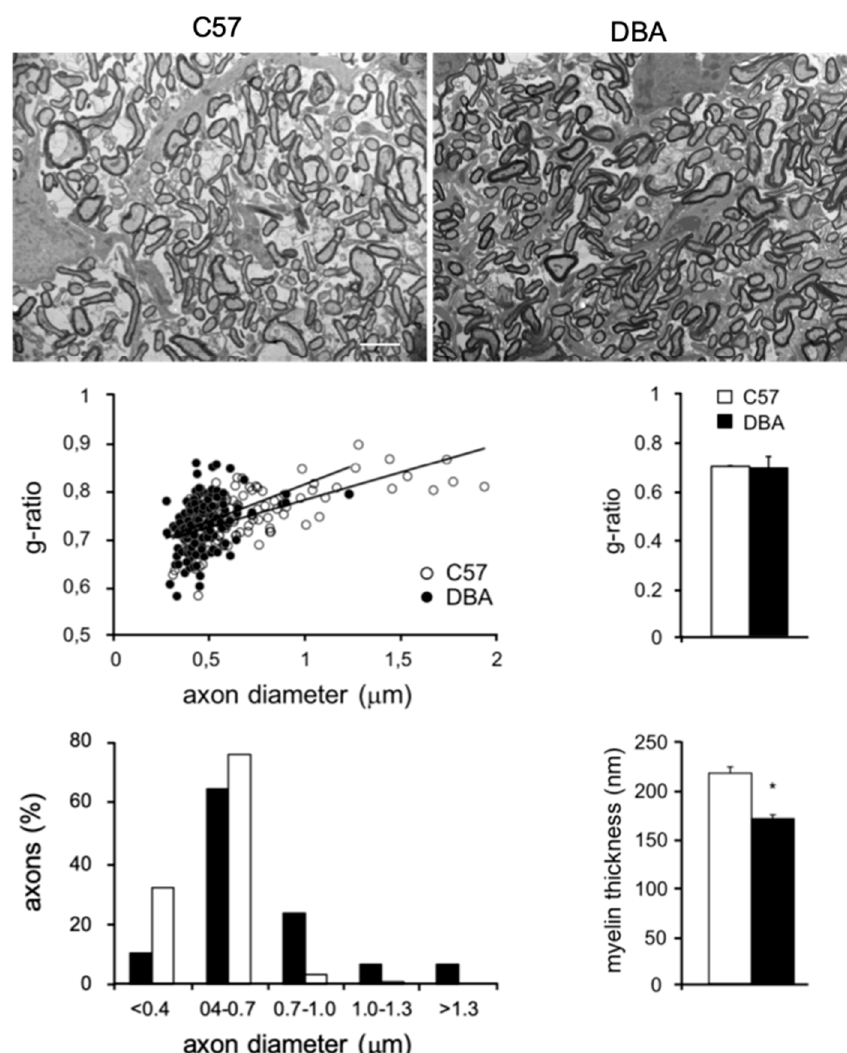
Figure 5. Smaller myelinated fibers in optic nerves of DBA mice. Electron microscopy (EM) analysis of optic nerves in cross-sections of either C57 or DBA, respectively, in mice at 2 months of age. Line graph: morphometric g-ratio analysis of myelinated axons in optic nerves of C57 and DBA. Bar graphs: morphometric analysis of myelinated axons showing g-ratio (averaged), axon diameter and myelin thickness for myelinated fibers. Scale bar, 2 µ m. Significant expression di ff erences: t -test (2-tailed) * p < 0.05.